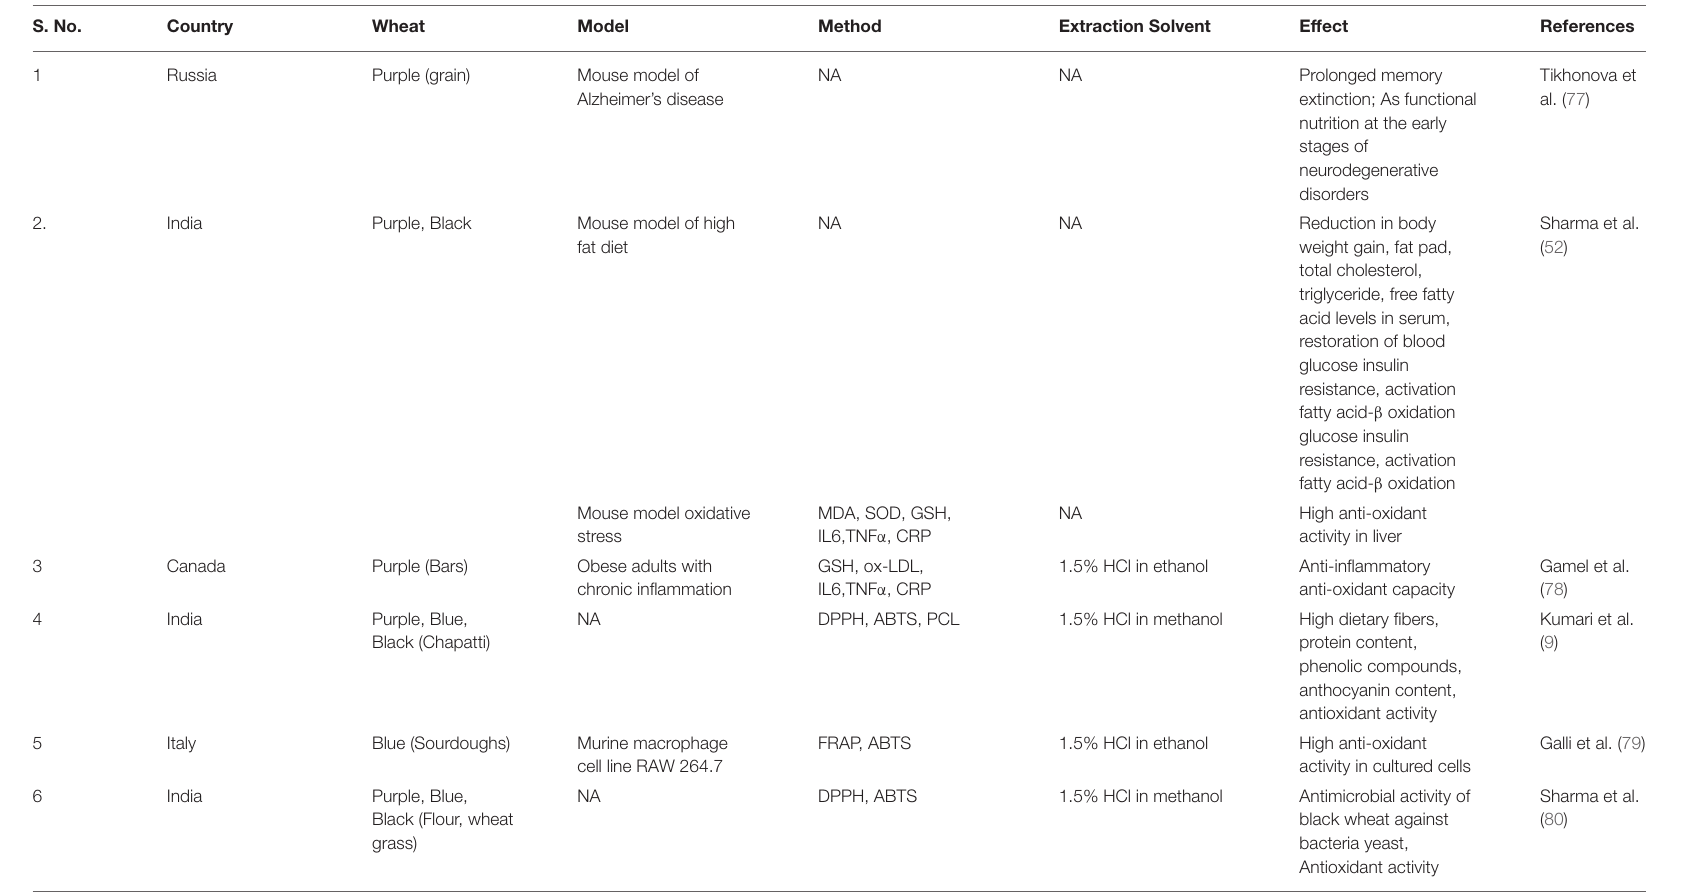
TABLE 4 | Compilation of in vitro and in vivo studies indicating the positive effect of colored wheat on human health. S. No.